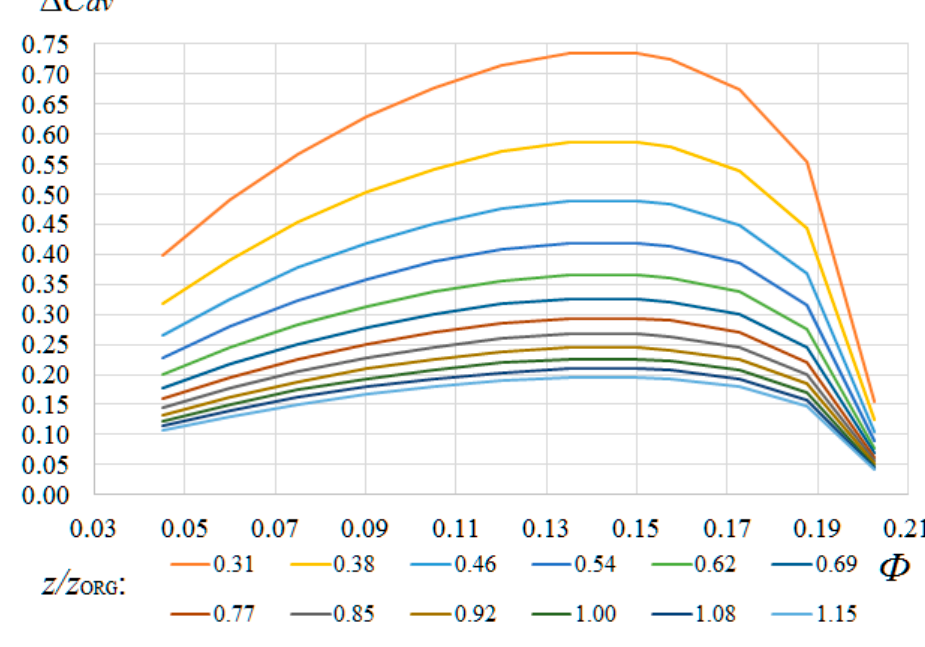
Figure 12. Vane load ∆ (cid:101) c av as a function of the flow coe ffi cient. b 5 OPT = 1.2 b 5 ORG .